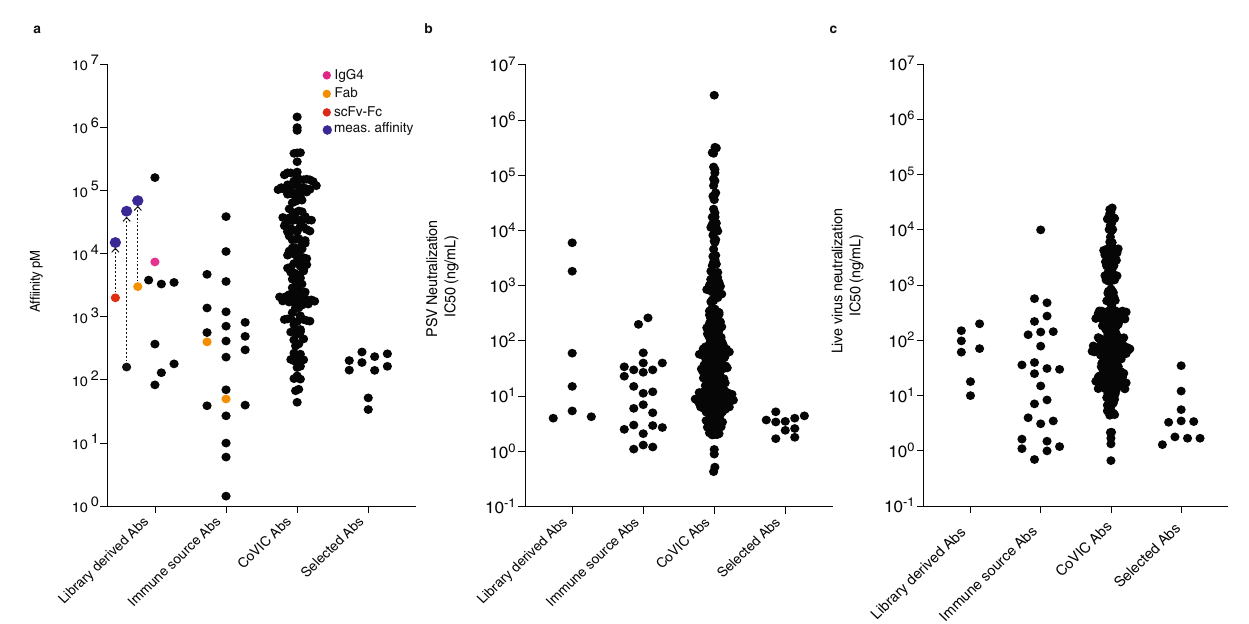
Fig. 5 Comparison of selected SARS-CoV-2 spike antibodies to the published record. a For each of the individual publications (see introduction) the IgG, Fab, or scFv-Fc with the highest af fi nity for the RBD is indicated (derived either from recombinant naïve antibody libraries “ Library derived Abs ” or from immunized animals or recovered Covid19 patients “ Immune source Abs ” ), together with the af fi nities of 181 antibodies in the CoVIC Ab database recognzing the RBD ( “ CoVIC Abs ” ). For the antibodies selected here ( “ Selected Abs ” ), the ten IgGs with the highest af fi nities for the RBD are indicated. For three of the naïve library derived antibodies we showed the reported values and those obtained here ( “ Meas. Af fi nity ” ). b For each of the individual publications the IgGs with the lowest IC 50 ’ s obtained using pseudovirus are indicated, while for the CoVIC database the IC 50 ’ s of 306 reported antibodies are indicated For the antibodies selected here, the 10 IgGs with the lowest pseudovirus IC 50 s are indicated. c For each of the individual publications the IgGs with the lowest IC 50 ’ s obtained using live virus are indicated, while for the CoVIC database the IC 50 ’ s of 288 antibodies assessed by UTMB are indicated (76 antibodies had IC 50 ’ s > 25 µ g/ml and are not included). For the antibodies selected here, the ten IgGs with the lowest livevirus IC 50 s are shown. For the publications as well as the antibodies selected here, the top antibody in each individual category is not necessarily the same antibody across all categories (e.g., a high-af fi nity antibody with poor IC 50 ’ s is reported in 5a, but not 5b or 5c). Furthermore, af fi nity, PSV, and live virus IC 50 s were not measured in all publications, so only the best measurements in each category that were reported are indicated. Source data are provided as a Source Data